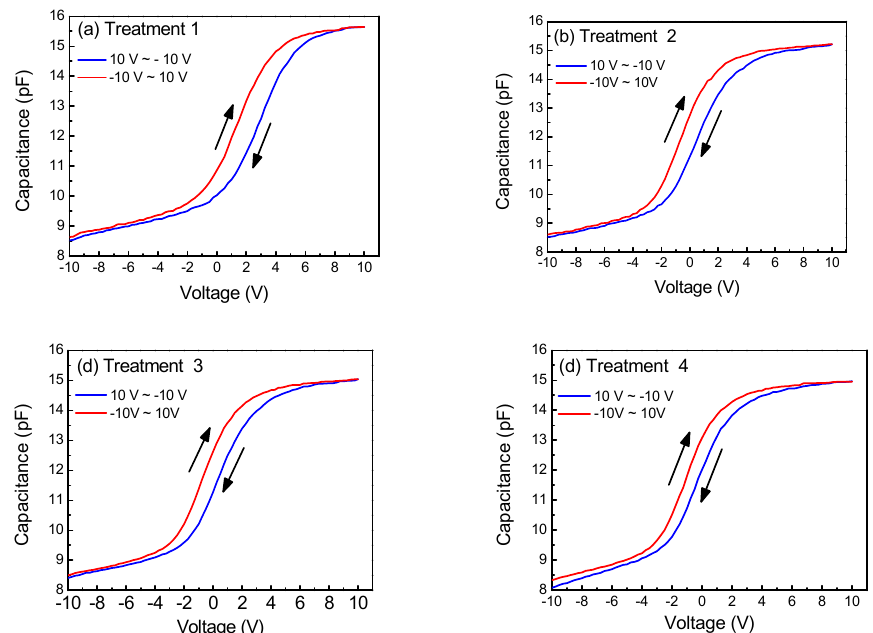
Figure 2. The Capacitance–voltage curves of MOS capacitors treated with ( a ) treatment 1, ( b ) treatment 2, ( c ) treatment 3, and ( d ) treatment 4.